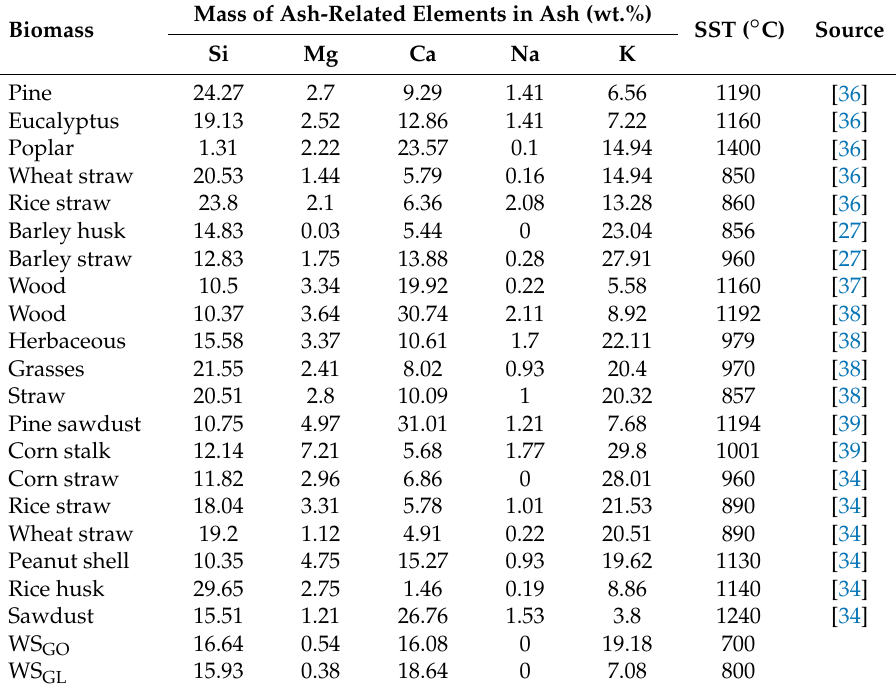
Table 3. Selected biomass data of ash-related elements and shrinkage starting temperature (SST).